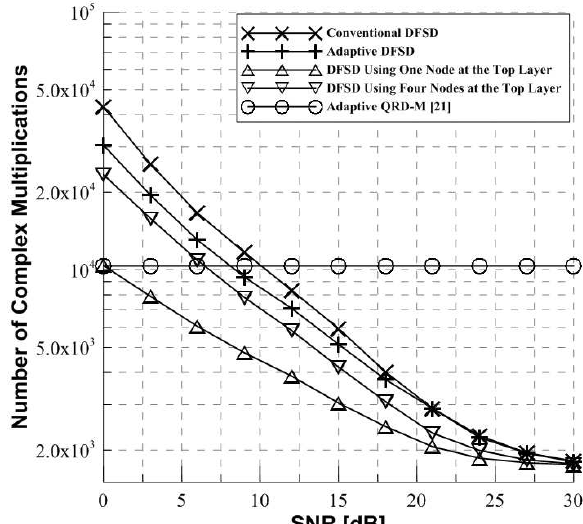
Figure 10. The complexity of the detection schemes in 4 × 4 MIMO-OFDM system with 16-QAM.